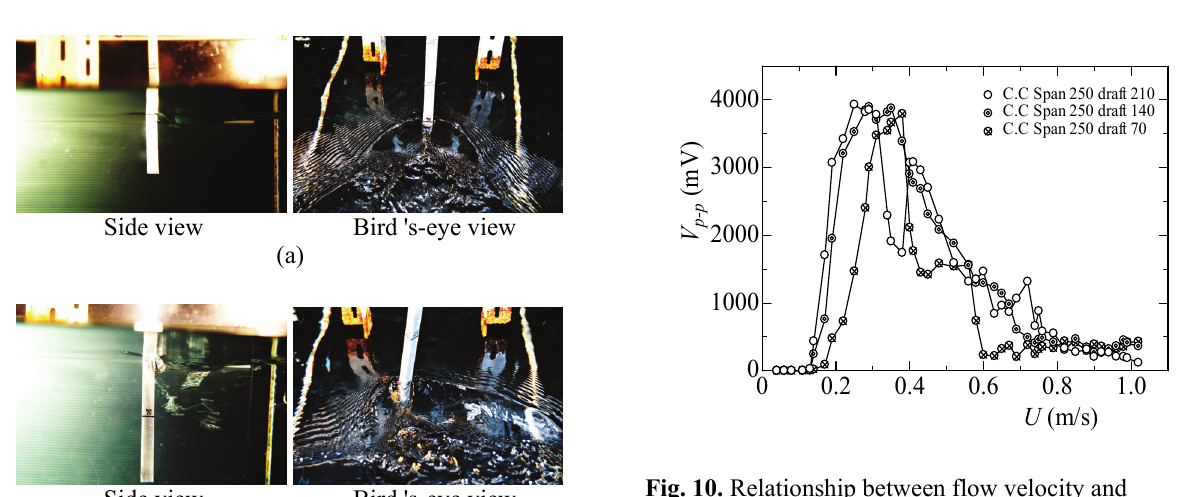
Fig. 10. Relationship between flow velocity and output voltage, in the case of circular cylinder, the piezo-electric buzzer was used